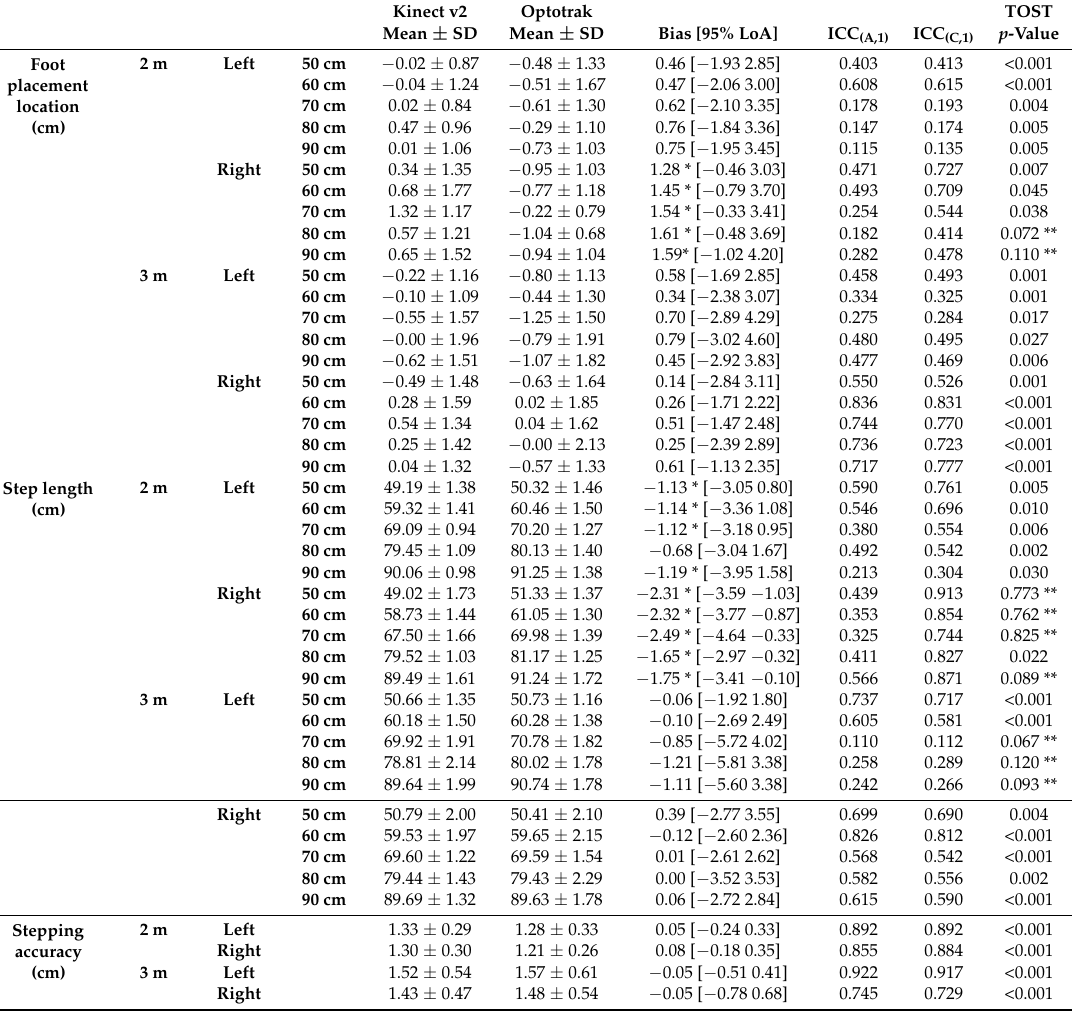
Table 1. Mean values, between-subjects standard deviations (SD), agreement statistics (bias, limits of agreement [95% LoA] and intraclass correlation coefficients for absolute agreement [ICC (A,1) ] and consistency [ICC (C,1) ]) and results of the two one-sided t -tests (TOST) for the foot placement locations, step lengths and stepping accuracies for all combinations of the independent variables Distance (2 m, 3 m), Side (left, right) and Imposed Step Length (50 cm, 60 cm, 70 cm, 80 cm, 90 cm). Kinect